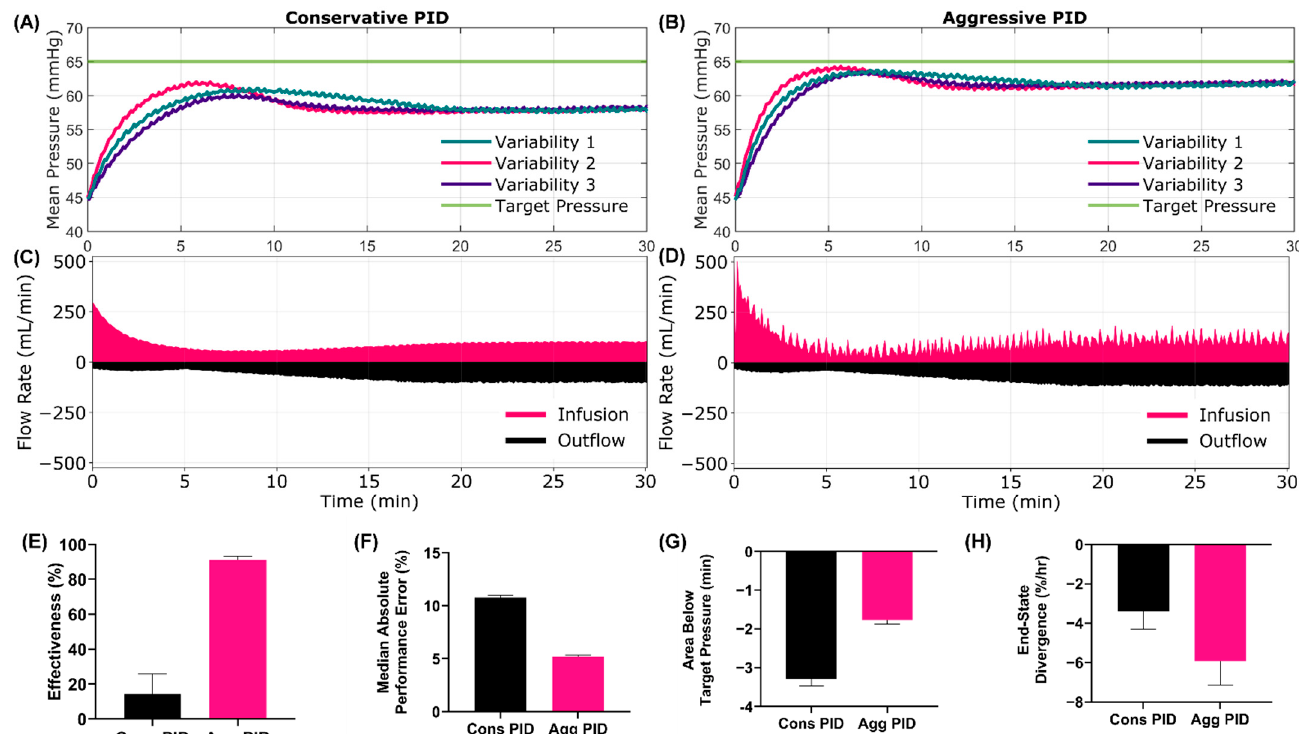
Figure 5. Scenario 10 Testing Results. Scenario 10 began at a low starting MAP with an active fast bleed, which clotted for 5 min when coagulopathy caused the hemorrhage rate to increase up to a maximum of 140 mL/min, where it stayed for the remainder of the testing scenario. WB infusate was used for this scenario. Results for the conservative ( A , C ) and aggressive ( B , D ) tuned PID are shown for ( A , B ) MAP and ( C , D ) infusion and outflow rate as the controller tried to reach a target MAP of 65 mmHg. For MAP plots, each of three subject variability runs are plotted individually while a single representative run is shown for the inflow/outflow plots. Average controller performance metrics for ( E ) effectiveness, ( F ) MDAPE, ( G ) area below target pressure and ( H ) end-state divergence are shown for both controller tunings for this scenario. Error bars denote standard deviation ( n = 3).